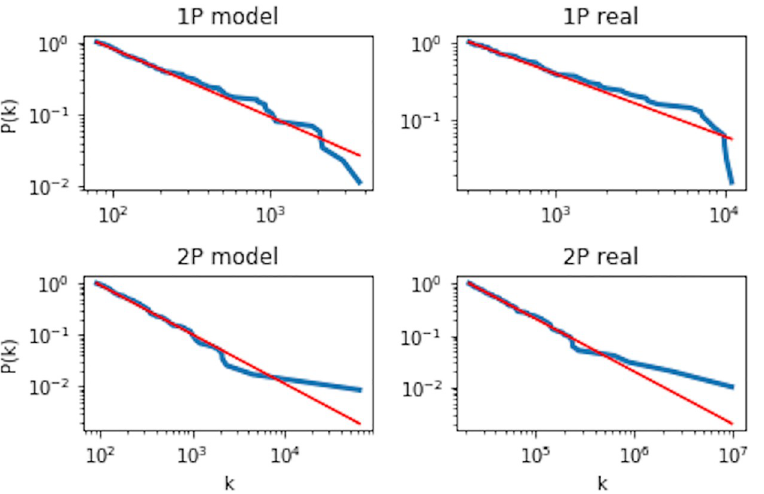
Fig 15. A comparison of the complimentary cumulative degree distribution between the empirical and synthetic network for both periods. All distributions are observed to display power-law behavior. The red line shows the power law function with an exponent of